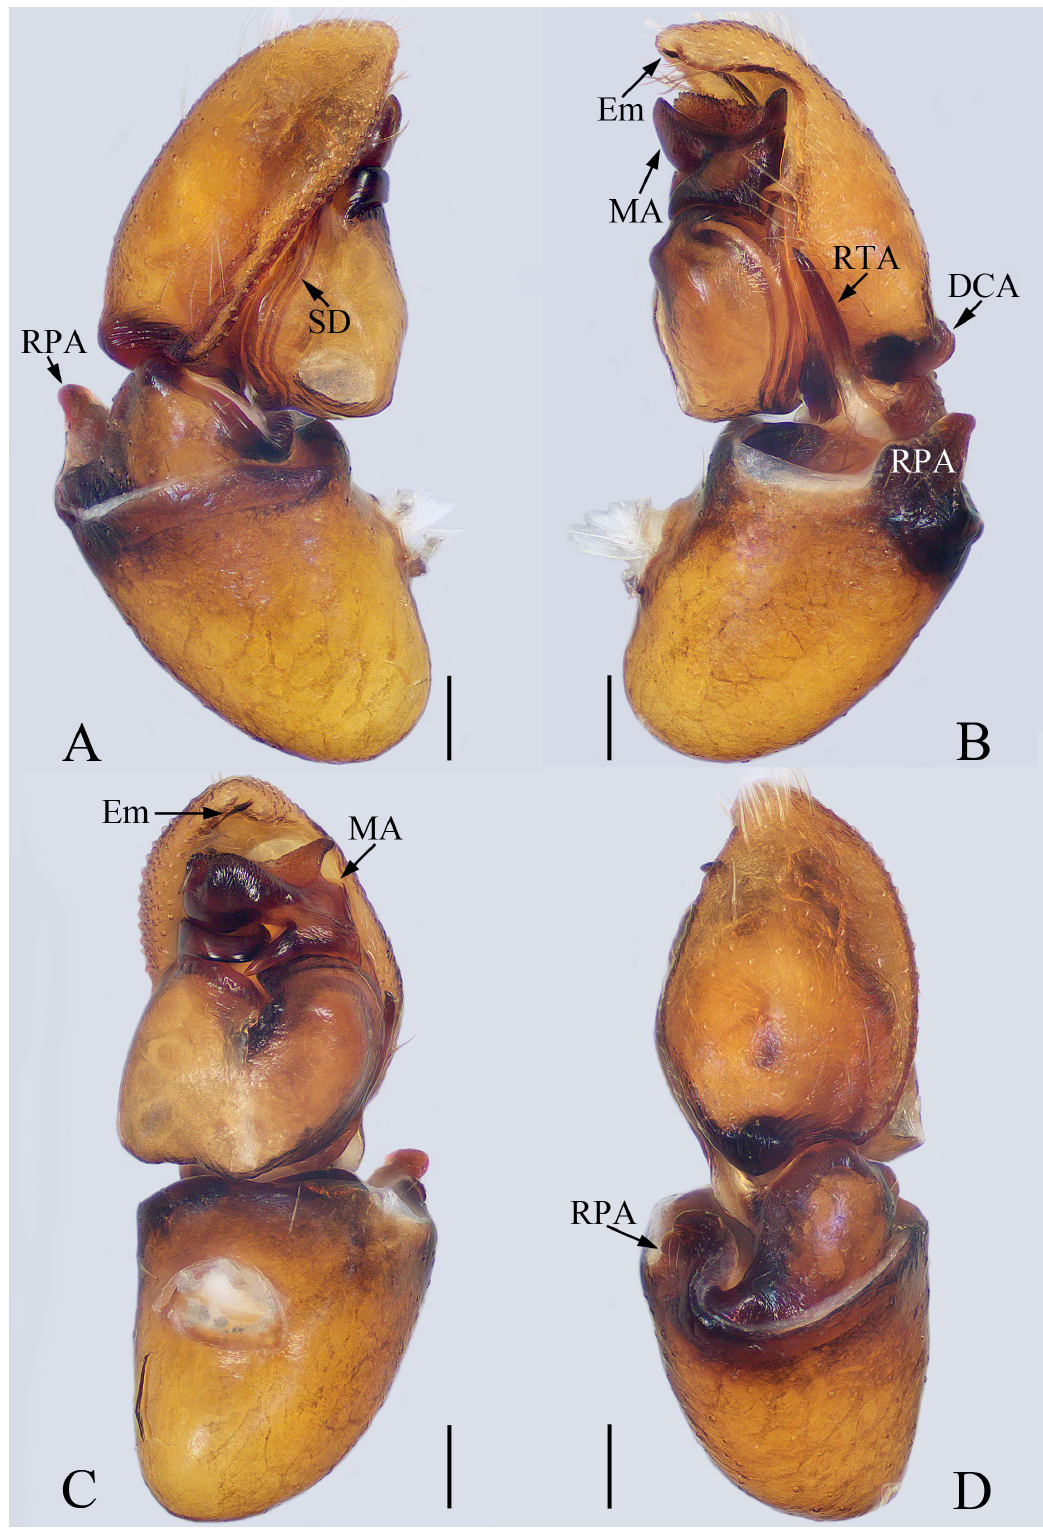
Fig. 7. Male palp of Synagelides logunovi sp. nov., holotype, ♂ (TRU-Salticid-0016). A . Prolateral view. B . Retrolateral view. C . Ventral view. D . Dorsal view. Abbreviations: see Material and methods. Scale bars = 0.1